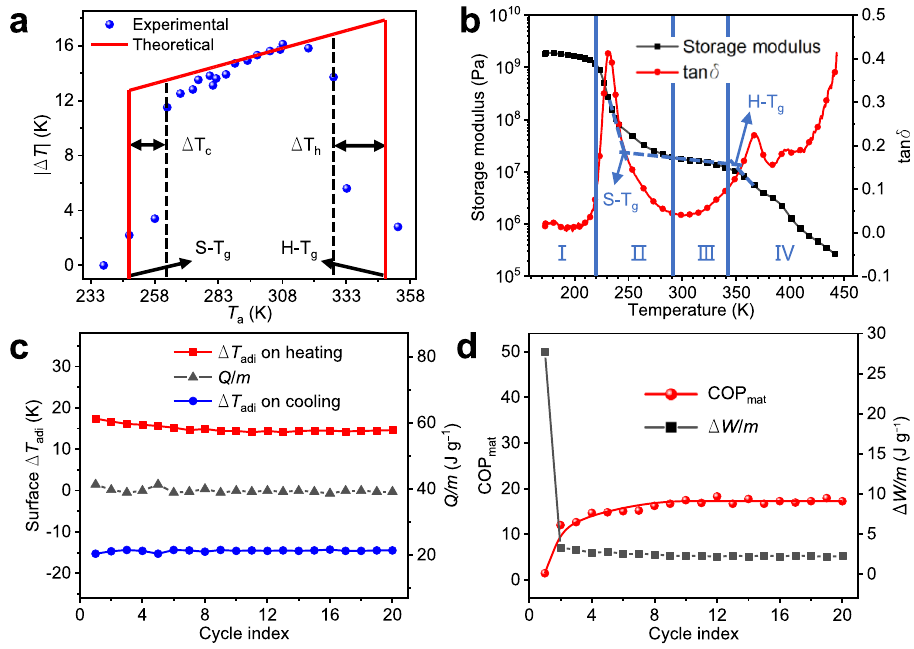
Fig. 3 Ambient temperature range and COP mat of TPEs-1. a Experimental and theoretical | Δ T | of TPEs-1 as a function of the ambient temperature under the ultimate strains during the cooling process. The theoretical change of | Δ T adi | is proportional to T a when the elongation ratio ( λ ) and c p are constant, and the slope is estimated as the ratio of | Δ T adi | = 15.3 K to T a = 298.15 K according to Supplementary Eq. (4) in Supplementary Discussion 3. b E ’ and tan δ versus temperature curves of TPEs-1. Region I is the glass state region of TPEs-1. Region II is the glass transition region of the soft segments. Region III is the rubber elastic plateau region. Region IV is the viscous fl ow region. c Surface Δ T adi evolution of TPEs-1 during 20 times of elastocaloric cycles with 600% strain. d COP mat and input work of unit mass in TPEs-1 during elastocaloric